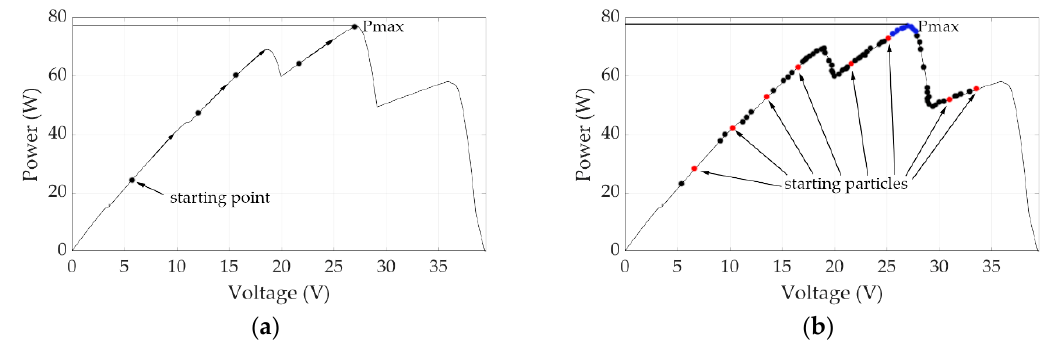
Figure 19. The GMPPT process trajectory for shading pattern 9 during the execution of: ( a ) the proposed Q-learning-based method and ( b ) the PSO-based method.